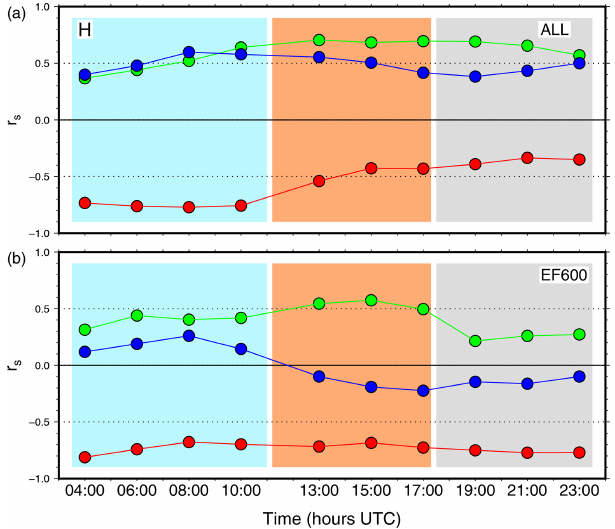
Figure 14. Same as Fig. 12 but between the sensible heat flux H and 10m wind speed (green), potential temperature at 10m (red), and SST